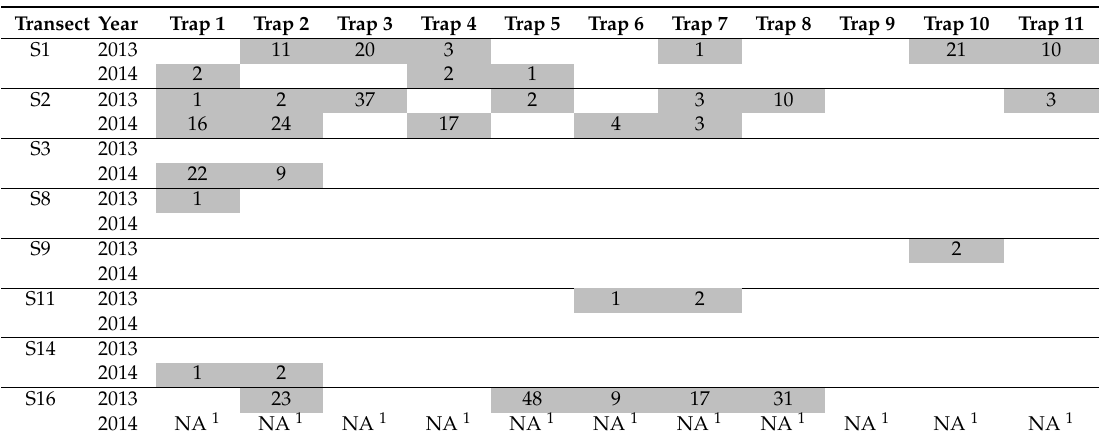
Table 1. Spatio-temporal development of the invasion front. Transects that detected L. humile in 2013 and/or 2014 using 11 traps perpendicular to the invasion front. Trap 1 is closest to the border of the invasion front. Filled squares, traps with L. humile (number) present; open squares, traps without L. humile